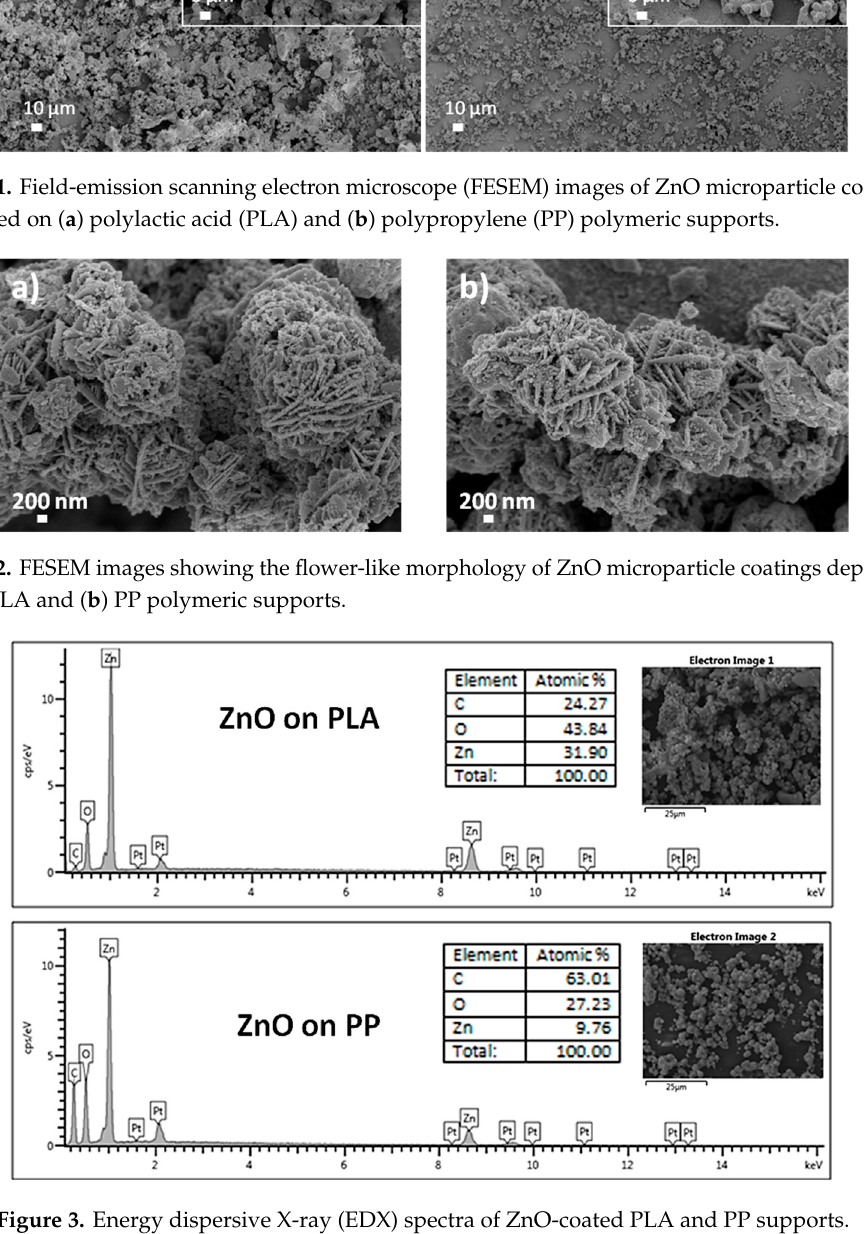
Figure 3. Energy dispersive X-ray (EDX) spectra of ZnO-coated PLA and PP supports.